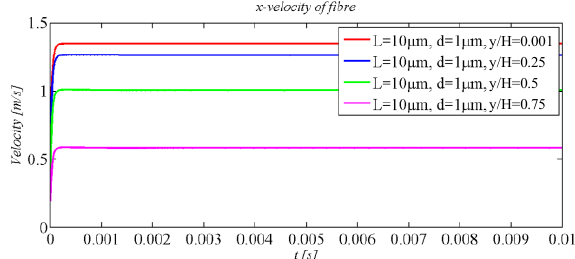
Fig. 5. Streamwise velocity component of fibre in